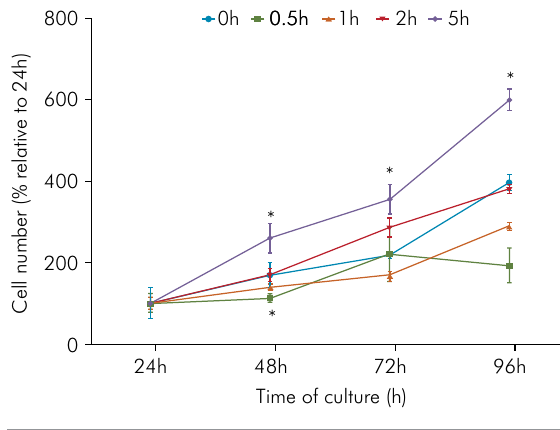
Figure 4. Effects of time between the tooth extraction and pulp removal and immersion into the culture media on the cell count. Data were normalized with the first day of cell culture (24 h) and expressed as mean ± standard error of two independent experiments performed in triplicates. Different letters indicate statistical difference (p < 0,005, ANOVA two-way, Bonferroni post-hoc test)